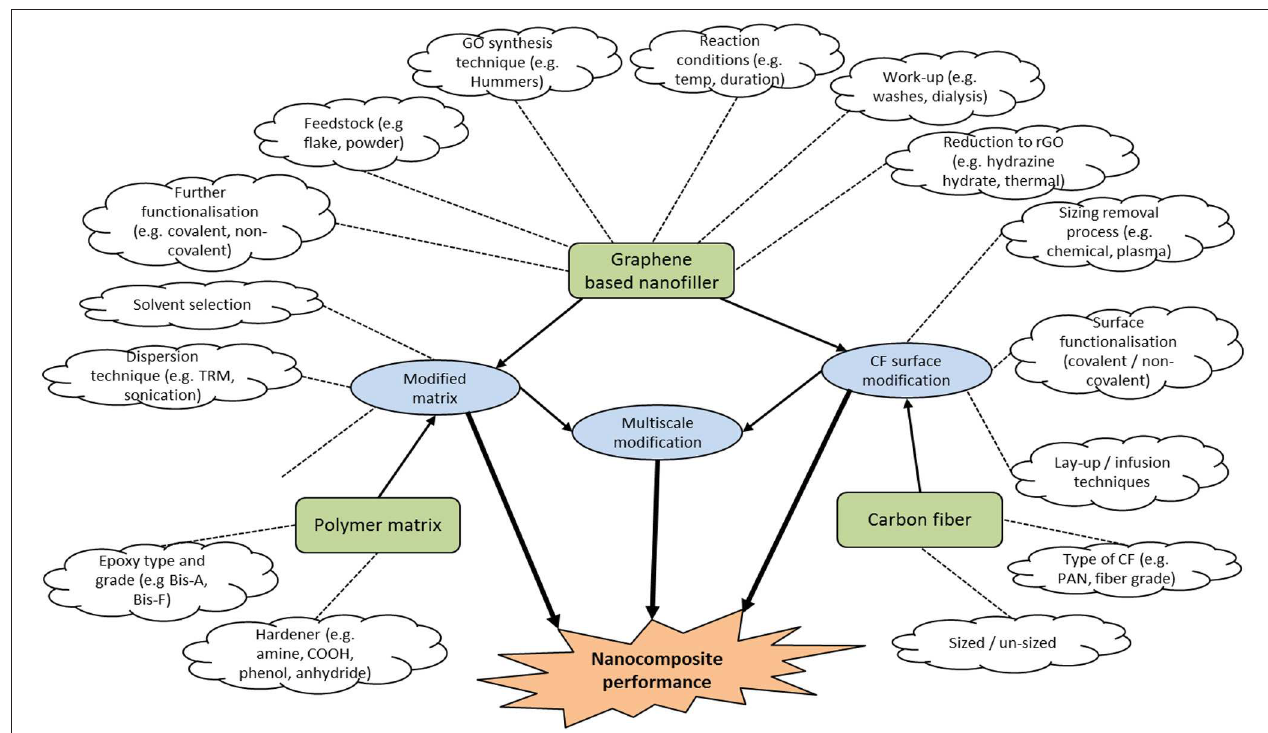
FIGURE 3 | Variables that affect nanocomposite performance. Variables are shown in white clouds which can apply to base materials (green boxes) and processes (blue